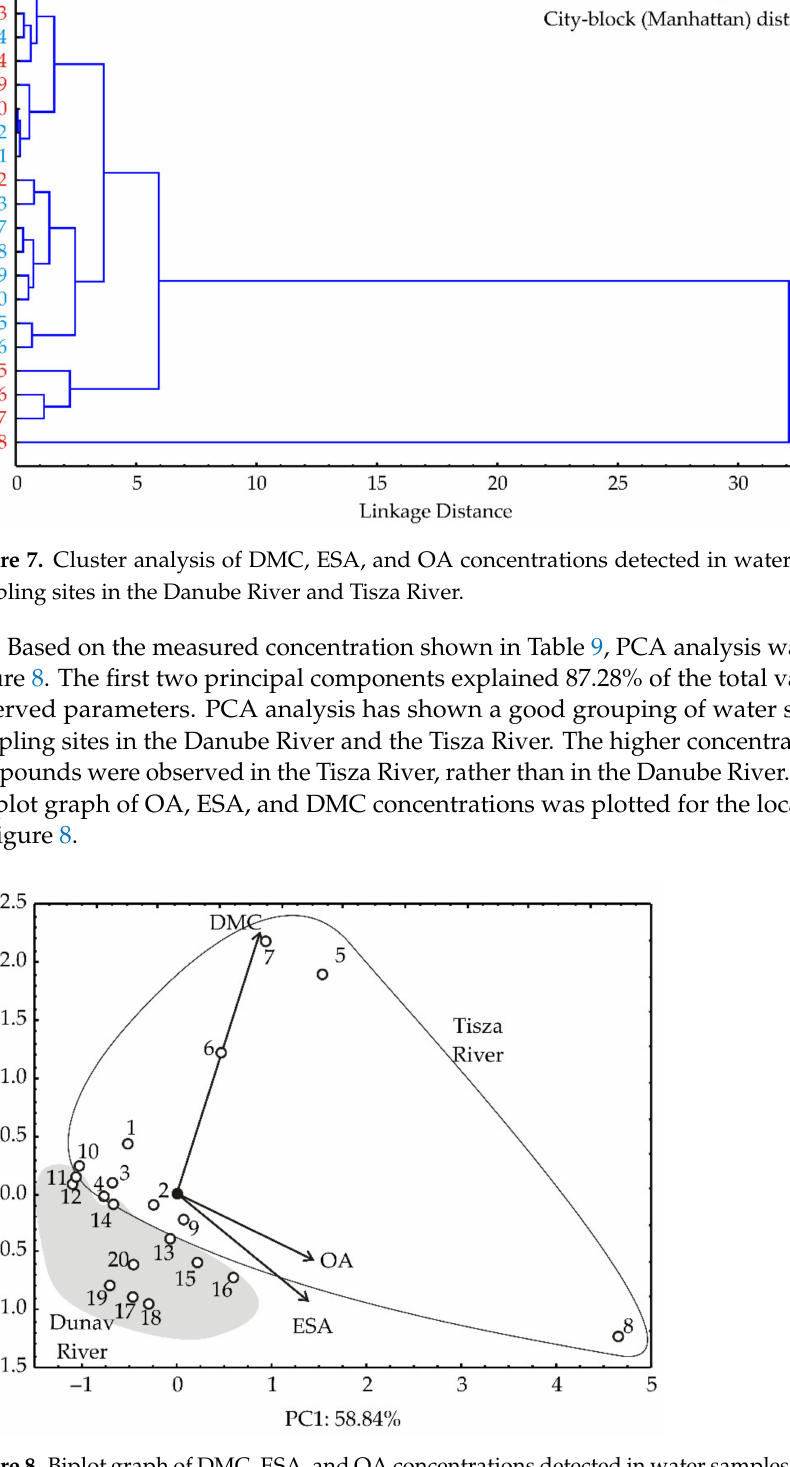
Figure 8. Biplot graph of DMC, ESA, and OA concentrations detected in water samples from sampling sites the Danube River and the Tisza River. OA—dimethachlor oxalic acid, ESA—dimethachlor ethanesulfonic acid and